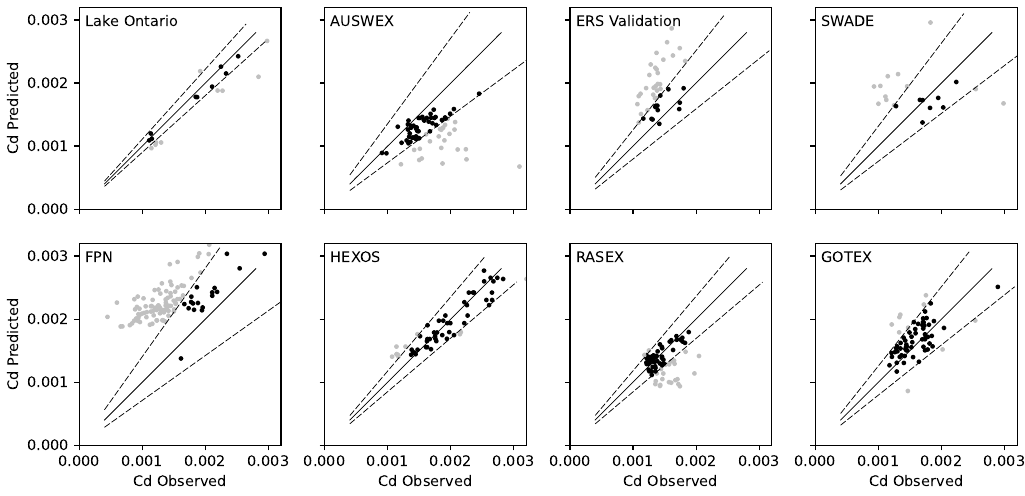
Figure 2. Measured drag coefficient vs. the value predicted by TY01 for eight datasets. Data points fall within the 90% confidence regions are shown in black points, and data points falling outside the 90% confidence regions are shown in grey points. Solid lines indicate the best fit between observations and predictions. Dashed lines represent the upper and lower boundaries of the 90% confidence